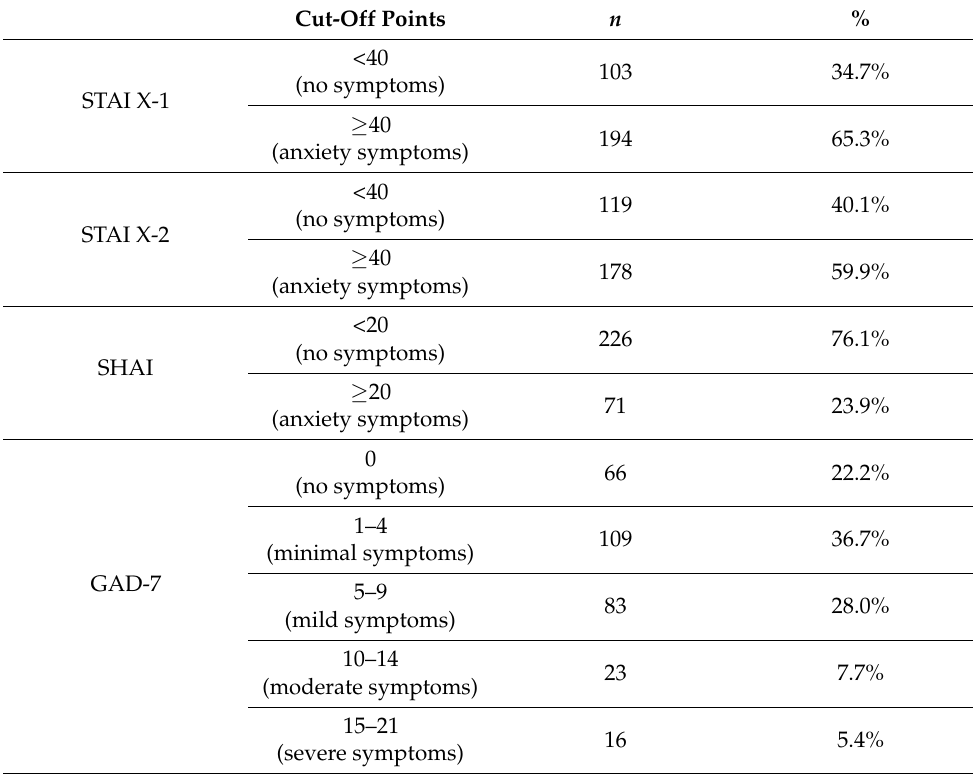
Table 3. Prevalence of anxiety symptoms among students of University of the Third Age according to the standardized cut-off points.